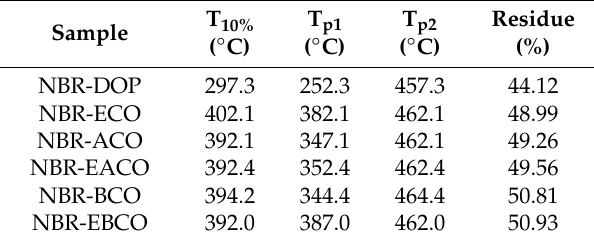
Table 6. TGA data of NBR vulcanizates.